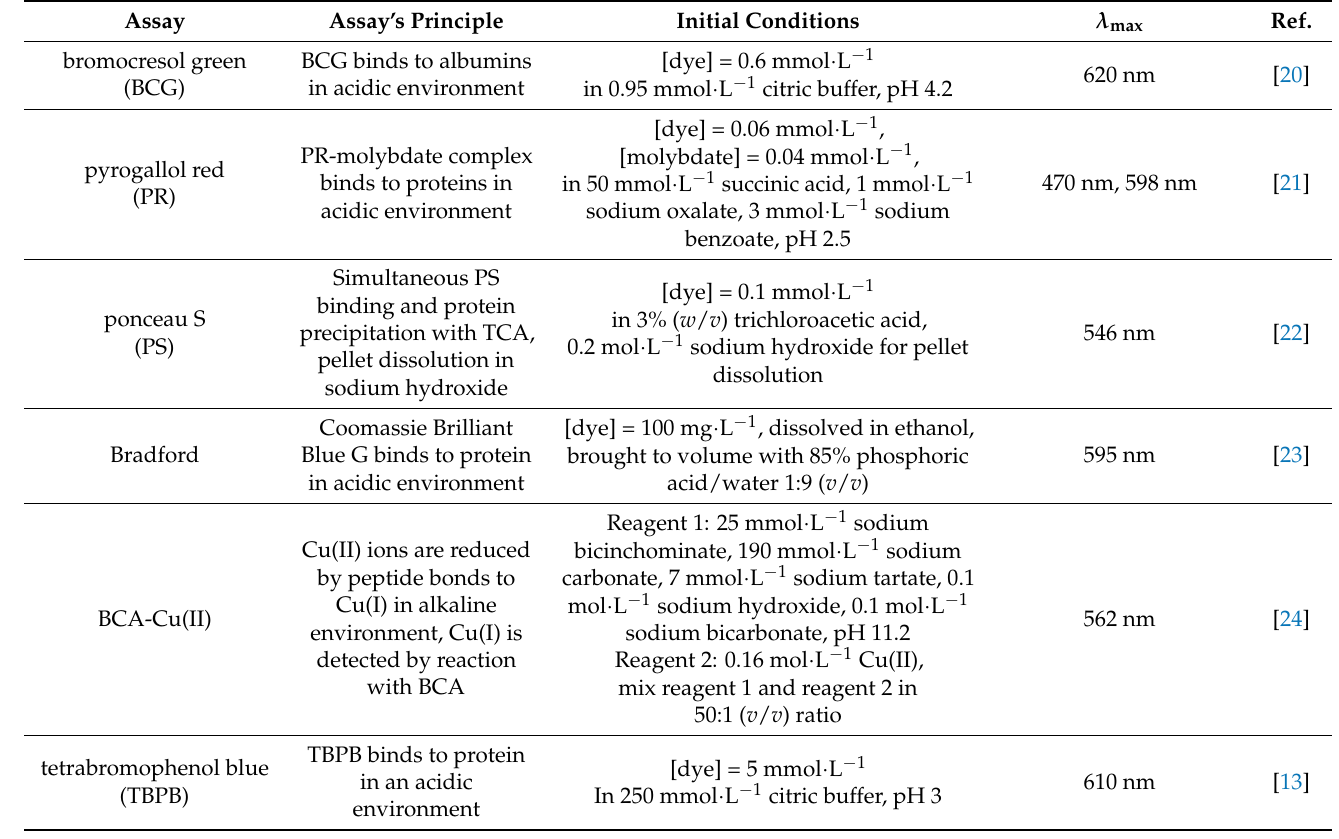
Table 1. Protein assays chosen for comparison and the initial conditions for these